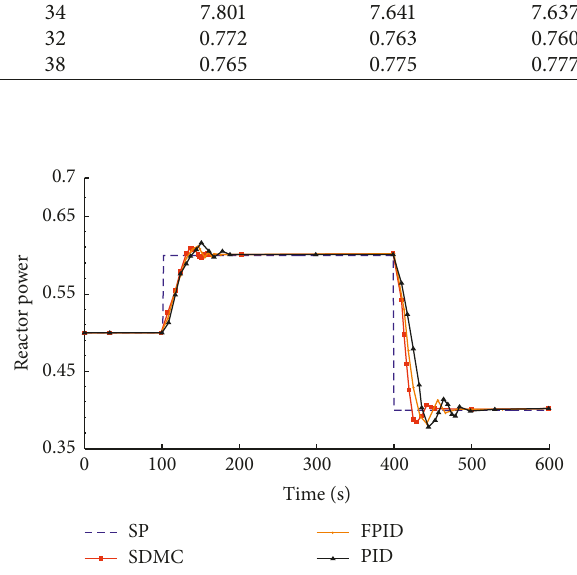
Figure 10: Comparison of different control